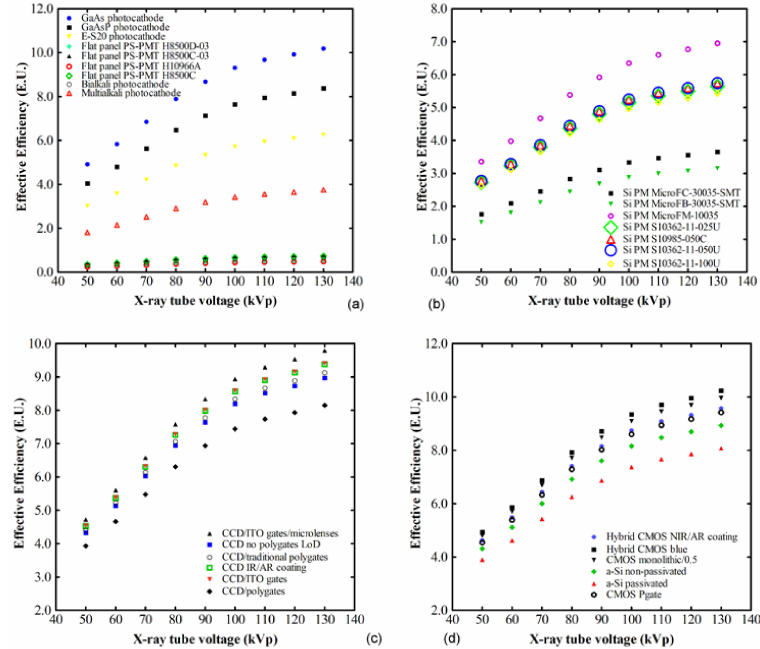
Figure 11. Effective luminescence efficiencies of ZnSe: Te combined with various sensors: ( a ) photocathodes; ( b ) silicon photomultipliers; ( c ) charge-coupled-devices; ( d ) complementary metal-oxide